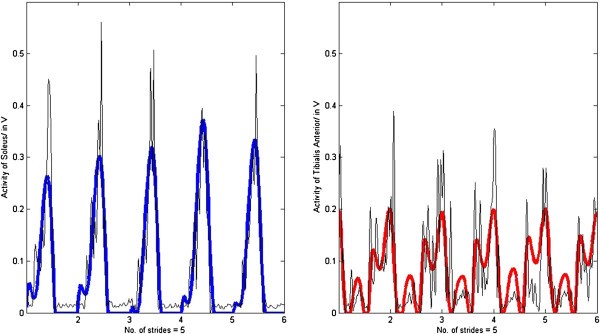
Rave = 0.80. Muscle activation of the soleus (RSOL = 0.90) and the tibialis anterior (RTA = 0.71) of subject #1 walking at 4.0km/h with insole forces and hip angles as inputs (bold lines represent the output from the SPG model and thin lines the experimental EMG data).